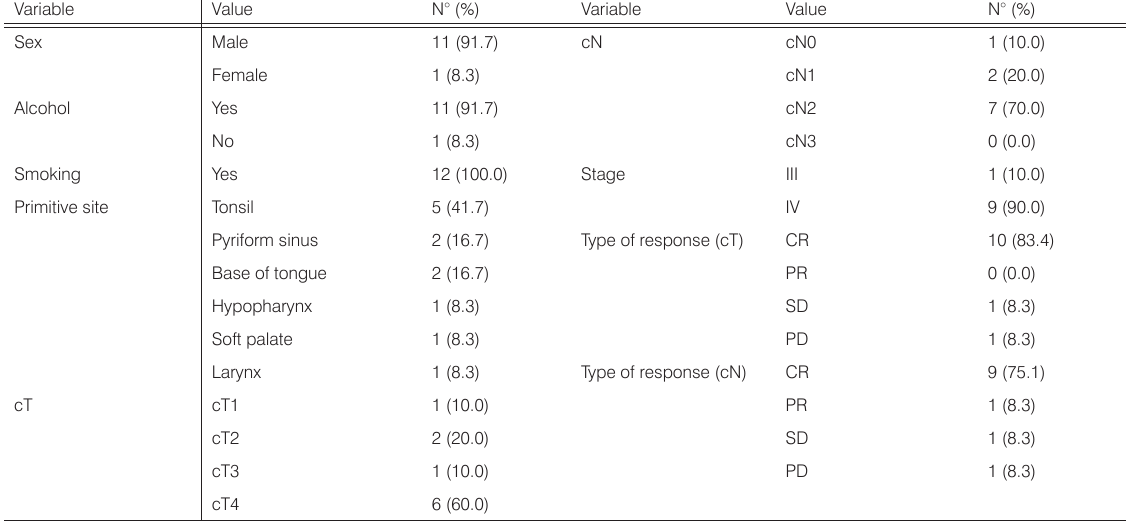
Table 2. The concomitant cisplatin-radiotherapy patients case study